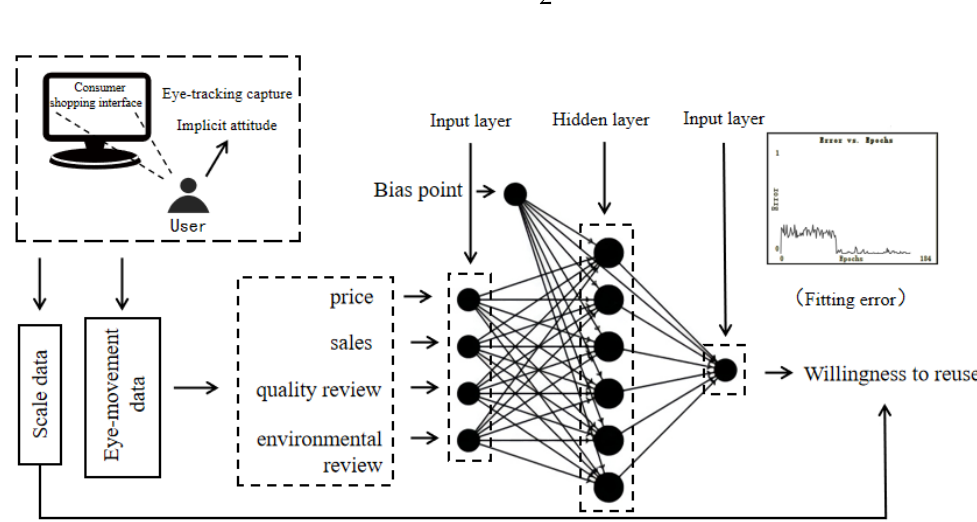
Figure 1. Data acquisition and BP network diagram of recycled water reuse intention.